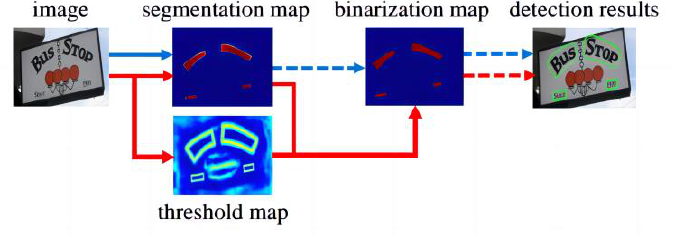
Figure 4. Comparison of traditional text detection algorithm and DBNet detection algorithm.